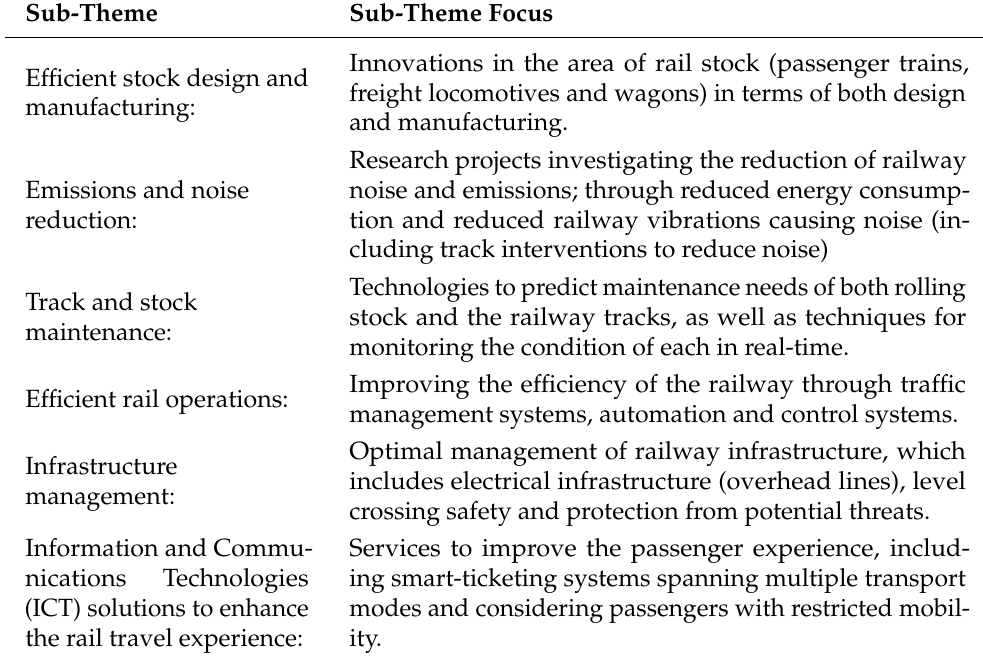
Table 5. Rail R&I